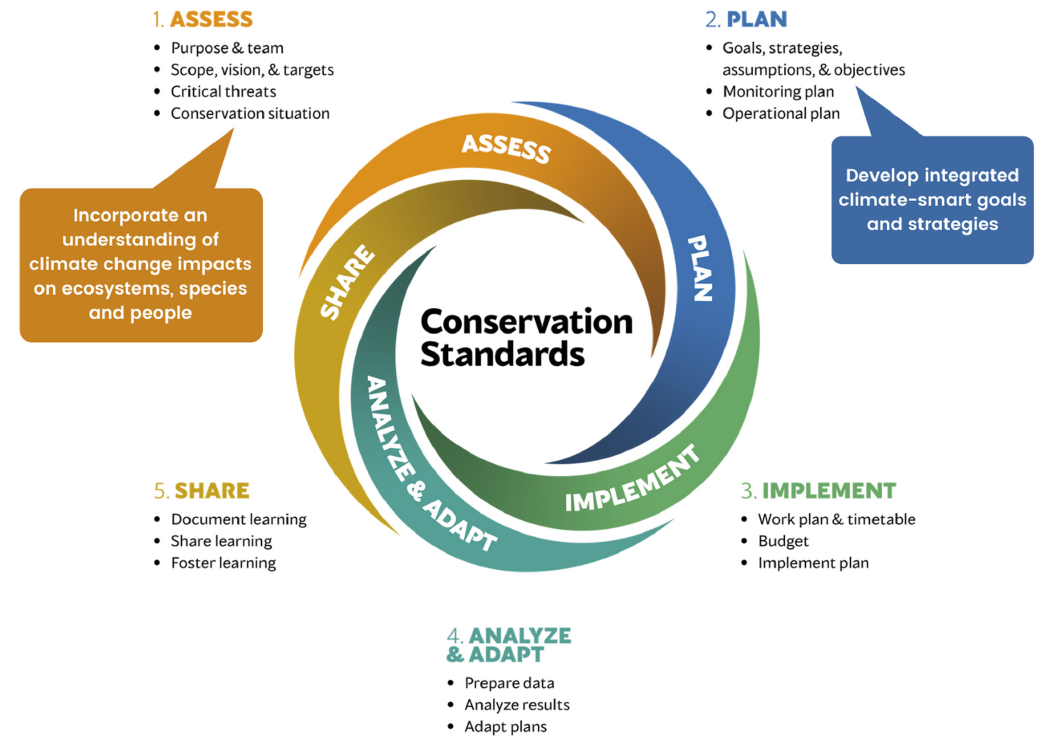
Figure 1. The Five Steps of the Conservation Standards callout boxes, highlighting components that have been adapted with permission from ref. [11] to integrate climate change.